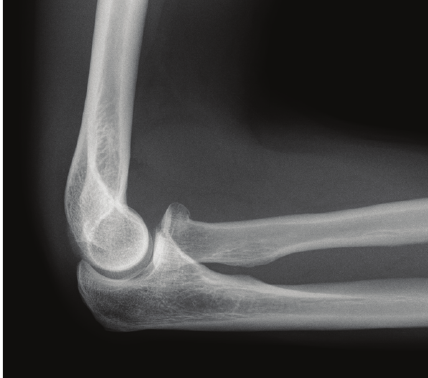
Figure 1: Mason 1 radial head fracture.